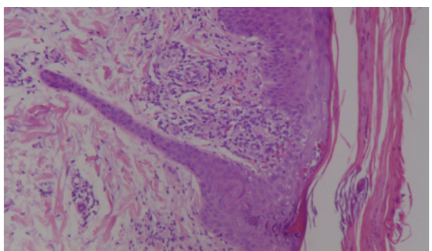
Figure 2: Pathology image of epidermis with parakeratosis and mild acanthosis and papillary dermis with perivascular lymphocytic infiltrate. Extravasation of red blood cells and basal layer vacuolar